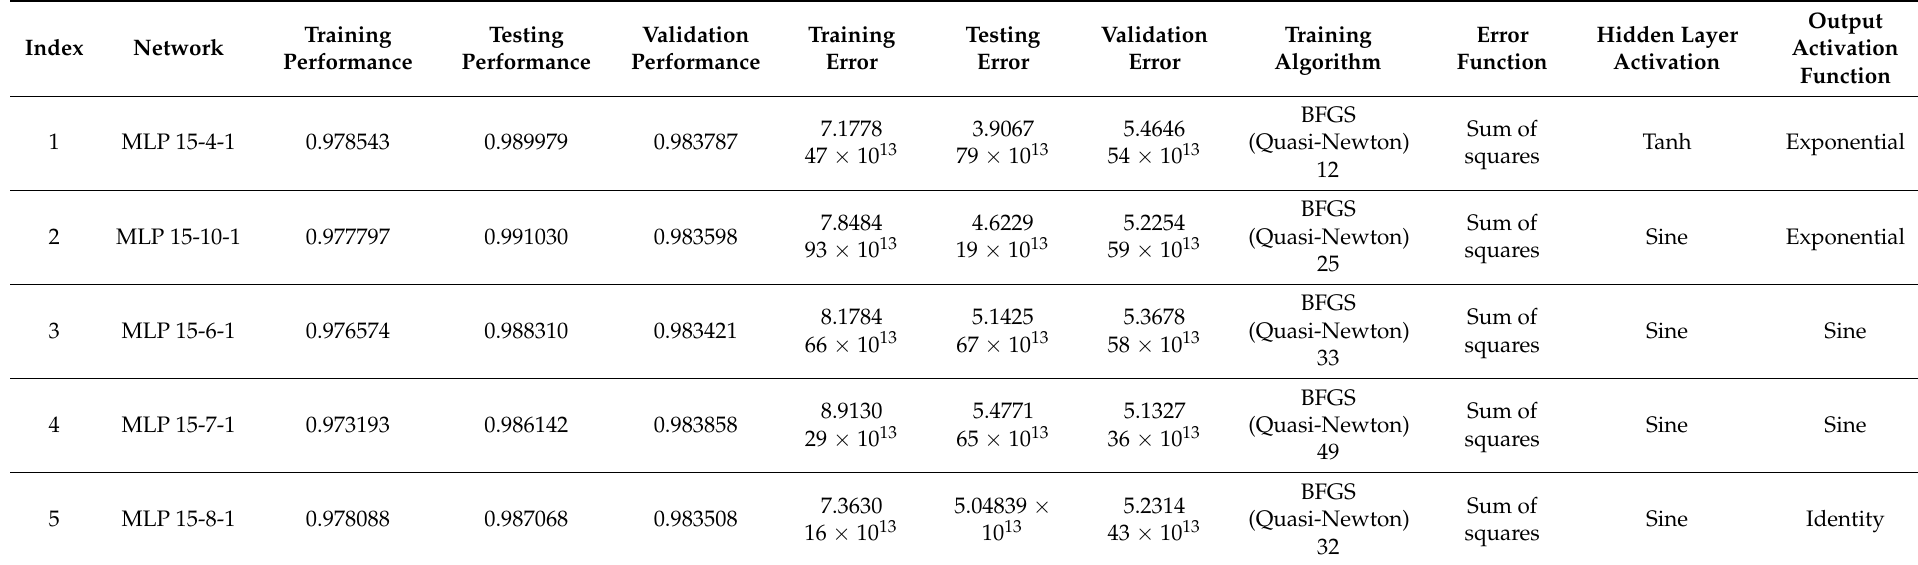
Table 4. Retained neural networks from Experiment